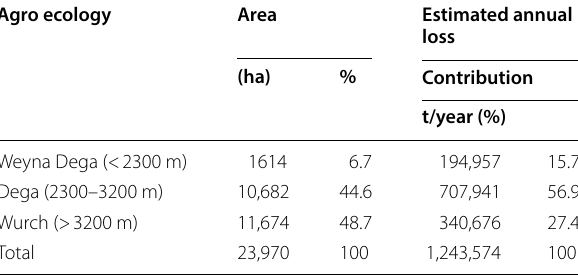
Table 8 Variations of soil erosion by agro